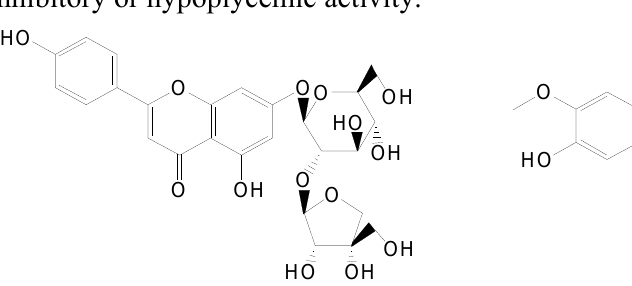
Figure 1 . TCMD-documented vegetable and legume components with aldose reductase inhibitory or hypoplycemic